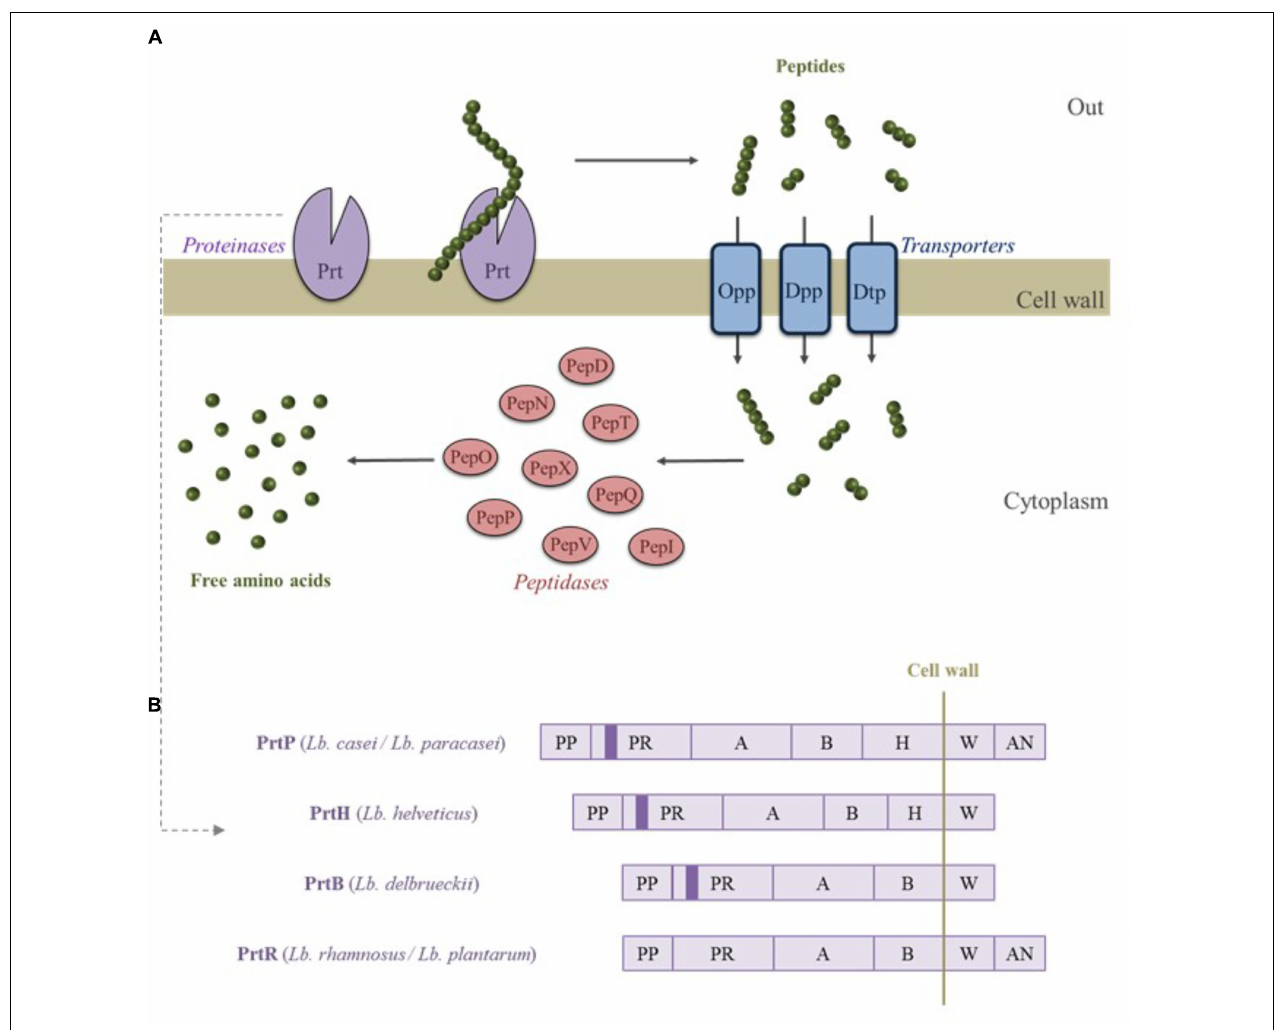
FIGURE 1 | Schematic representation of the proteolytic system of Lactobacillus spp. (A) . Protein hydrolysis is initiated by cell envelope proteinases (CEPs and Prt) and the resulting peptides are then transported inside the cell. Peptides are finally transformed into free amino acids by different peptidases. Diagrammatic representation of CEPs from different Lactobacillus species (B) . PP, pro domain; PR, catalytic domain; A, A-domain; B, B-domain; H, helical domain; W, cell wall spacer domain; AN, membrane anchor domain. The plain color in the catalytic domain represent the insertion I domain. Adapted from Sadat-Mekmene et al.